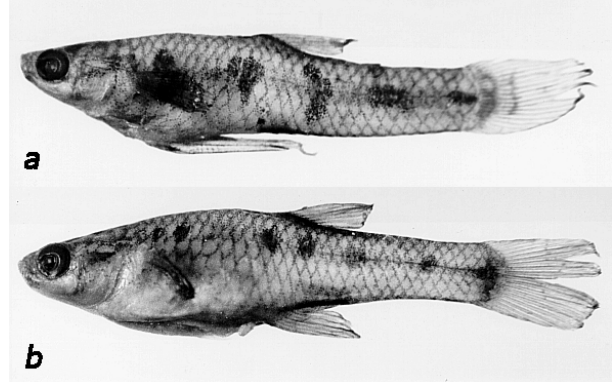
Fig. 11. Cnesterodon omorgmatos : (a) holotype, male, MCP 22741, rio das Torres, Pinhão, Paraná, Brazil. 24.3 mm SL; (b) paratype, female, MCP 22742, 27.9 mm SL, collected with the holotype.